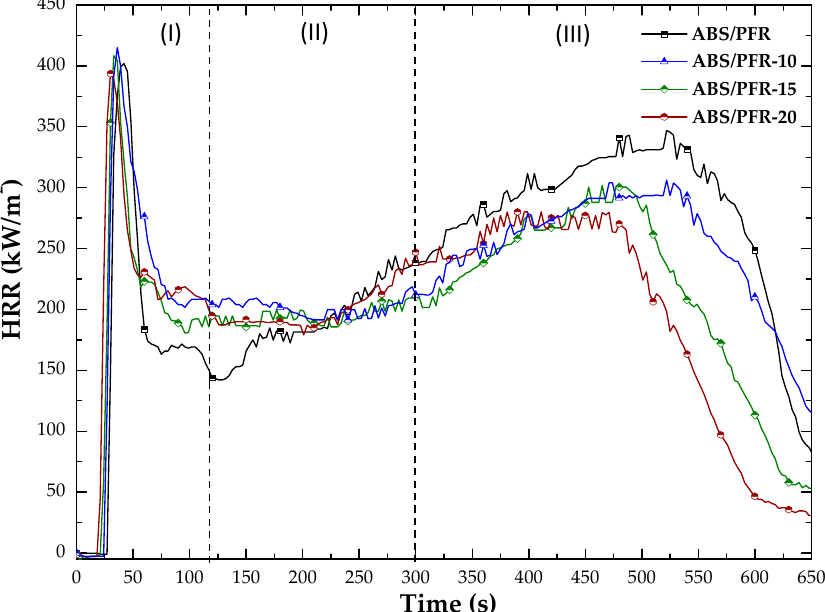
Figure 13. Characteristic HRR curves of unfoamed and foamed ABS/PFR parts showing the three main combustion